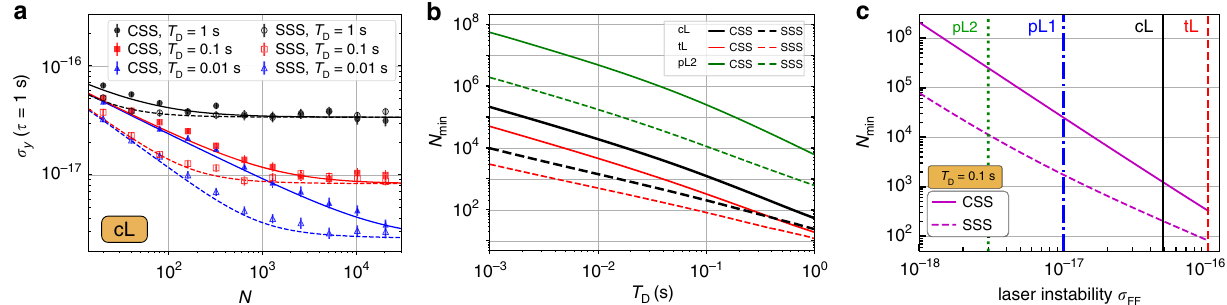
Fig. 3 Approaching the optimal stability and scaling of the critical particle number. a Particle number scaling towards the lower bound σ min for T D = 1s, 0.1s, 0.01s. The stability for each N is optimized over the Ramsey time. Compared are uncorrelated atoms in a coherent spin state (CSS, full lines and symbols) and squeezed spin states (SSS, dashed lines and empty symbols). Error bars are one standard deviation. b Minimal required particle number for reaching the stability limit with uncorrelated particles (full lines) or spin squeezed initial states (dashed lines). c Increase of the critical particle number N min with improved laser stability for coherent spin states and squeezed spin states. Vertical lines show the four highlighted laser types described in the main text. The labels (tL, cL, pL1, pL2) denote the respective laser phase noise, as speci fi ed in Table 1, in all parts of the fi gure. We use the transition frequency ν ≈ 429.228THz of 87 Sr 0